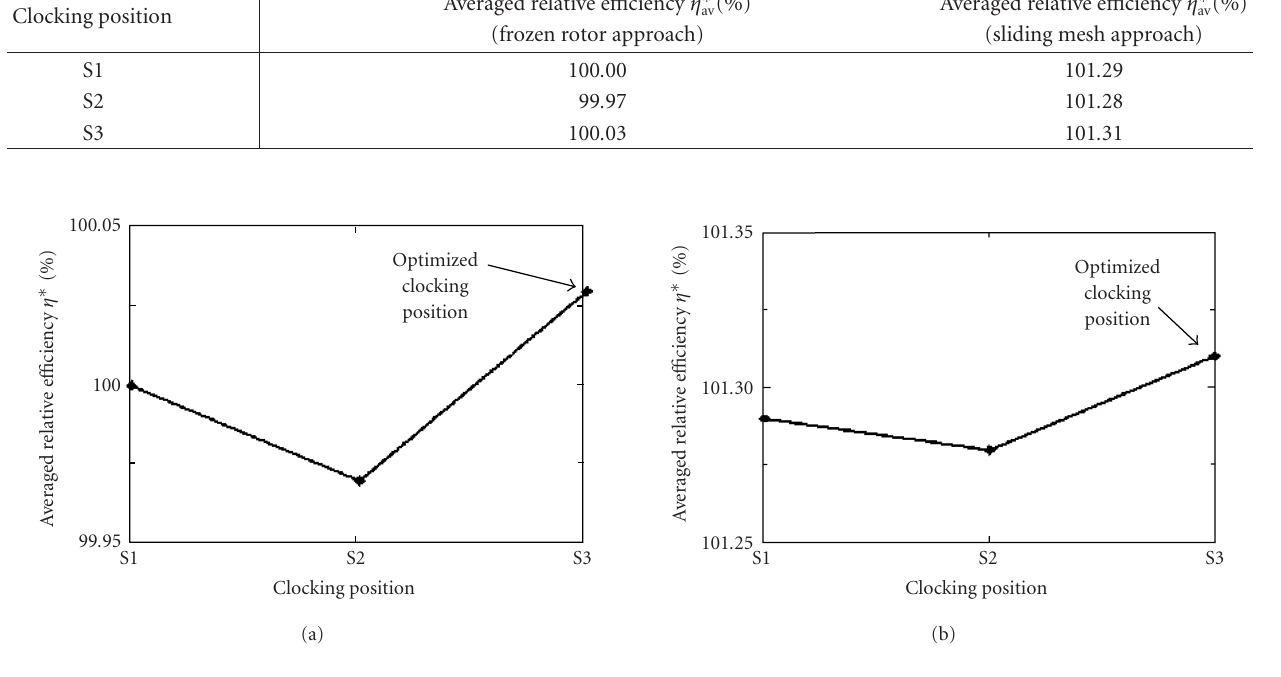
Figure 9: Averaged relative e ffi ciency distributions. (a) Frozen rotor approach, steady calculation. (b) Sliding mesh approach, unsteady